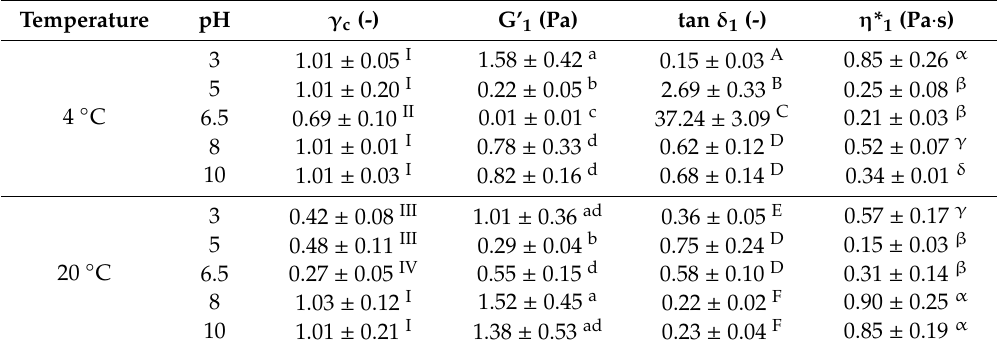
Table 2. G’, tan δ and η * at 1 Hz (G’1, tan δ 1 and η *1) and critical strain of the hydrogels as a function of the pH (3, 5, 6.5, 8 and 10) and the gelation temperature (4 and 20 ◦